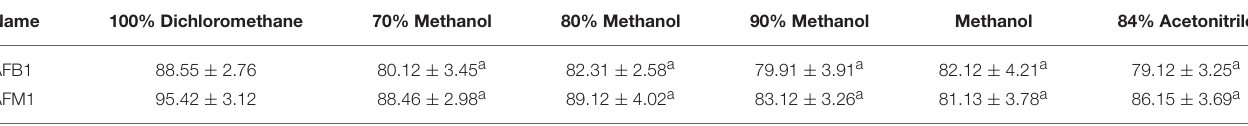
TABLE 1 | Effect of extraction solvent on recovery (%) of AFB1 and AFM1.